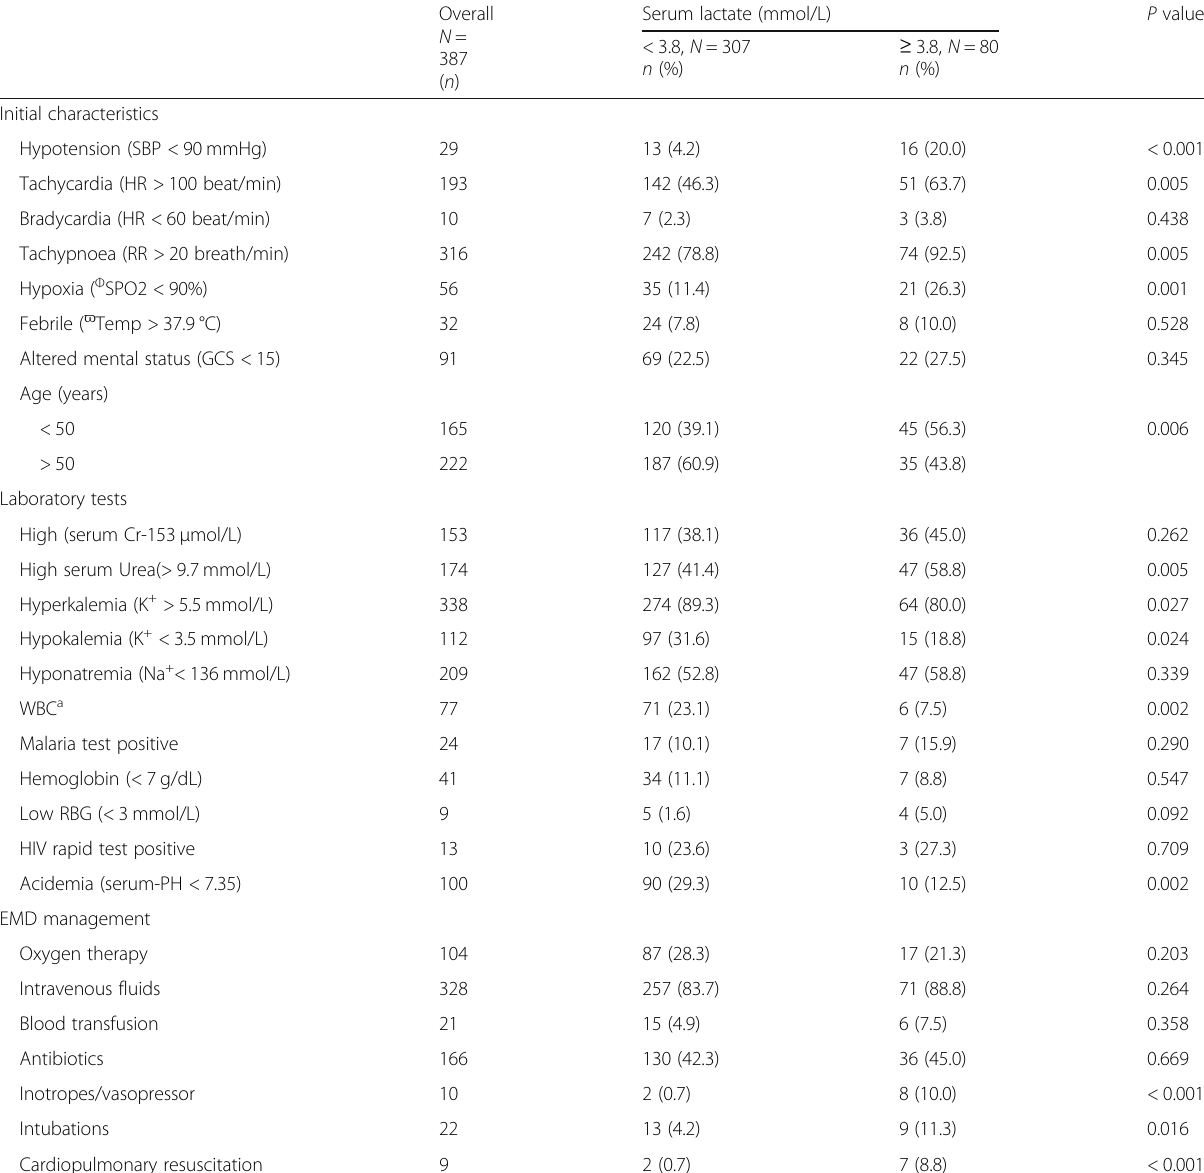
Table 4 Baseline variables, investigations and management by lactate level